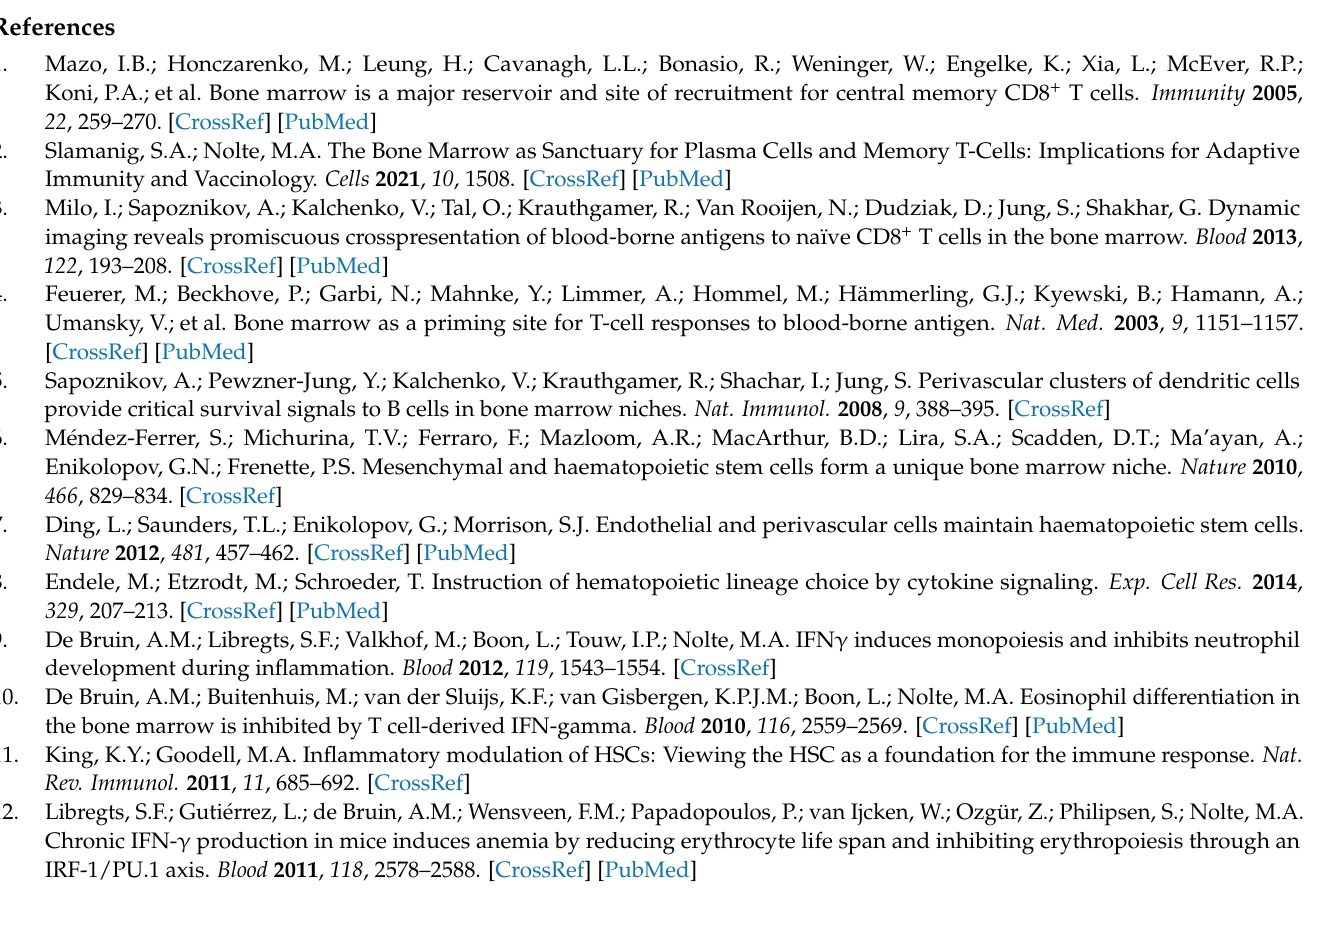
Figure S3: Gene ontology enrichment analysis of RNAseq from BM DCs vs splenic DCs, Figure S4: Imagestream analysis of zymosan uptake by DC, Figure S5: In vivo zymosan uptake by BM cells & impact on neutrophil numbers, Figure S6: Gating strategy for LSK cultures and impact of blocking G-CSF, Table S1: Genes differentially expressed between DCs in BM vs.